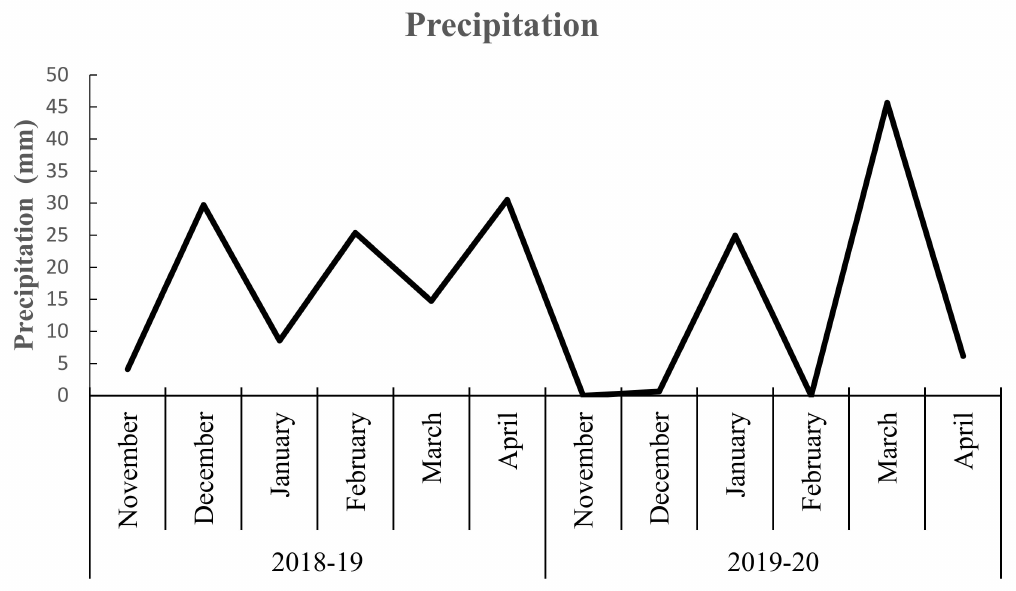
Figure 2. Monthly precipitation during crop growing seasons (2018–2019 and